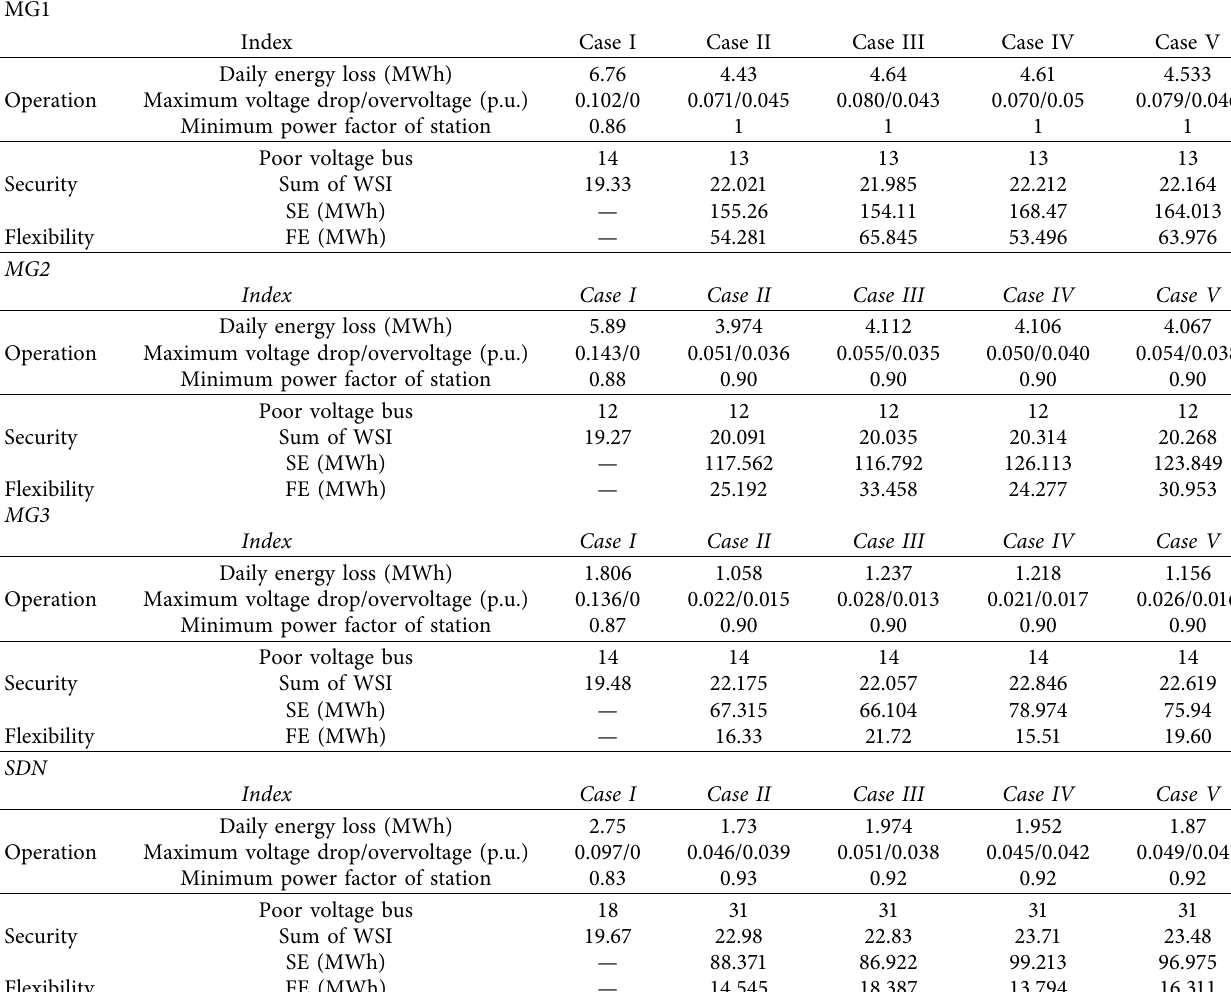
Table 5: The values of different technical indices in MGs and